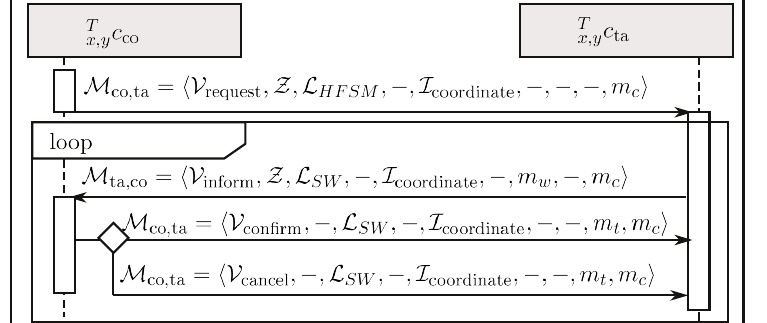
coordinate interaction protocol. The initiator agent a co , that contains the pair of buffers Figure 8. co,ta I T x , y c co , starts the interaction, while the participating agent a ta , that contains the pair of buffers takes part in it. The dashed lines are lifelines, arrows represent particular communicates. A diamond indicates an alternative in messaging. The sub-diagram ’loop’ means the repetition of its contents.